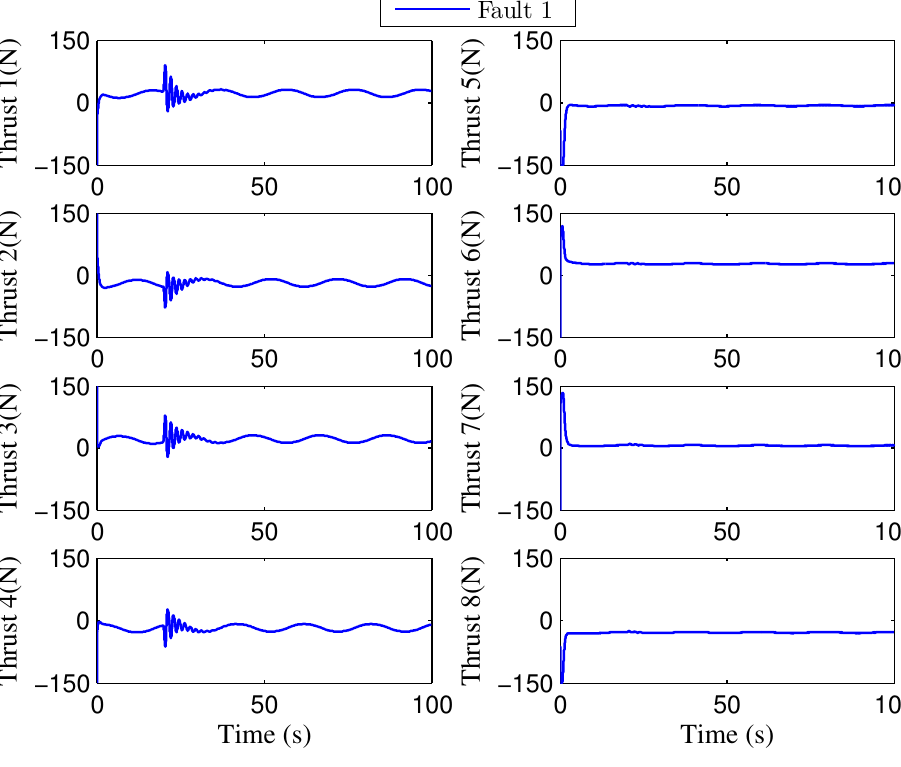
Figure 7. Outputs of thrusters with fault 1 under APISM-FTC